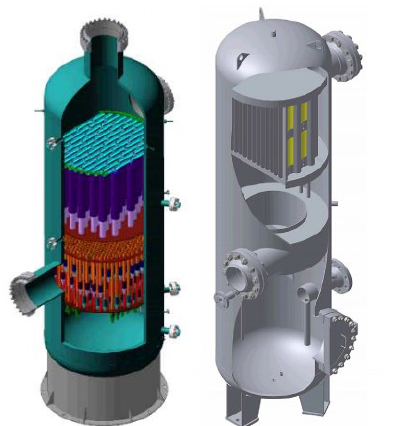
Figure 1. The separation equipment designed at the R&E Center for Industrial Engineering of Sumy State